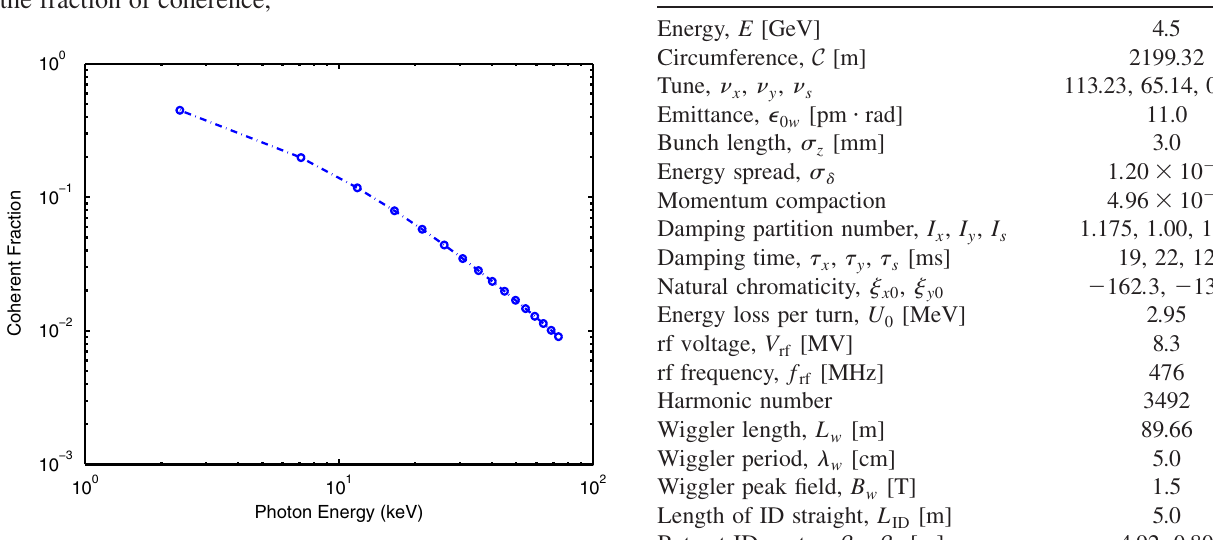
FIG. 5. Coherent fraction for the PEP-X ultimate storage ring.